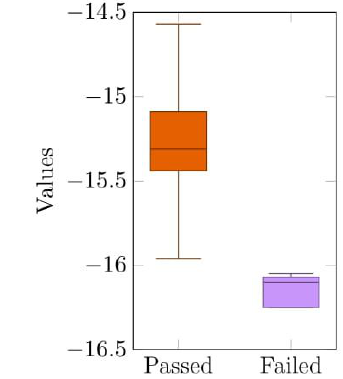
Figure 2. Box diagram-Test Cell4_3_S21 [910–980 Mhz].